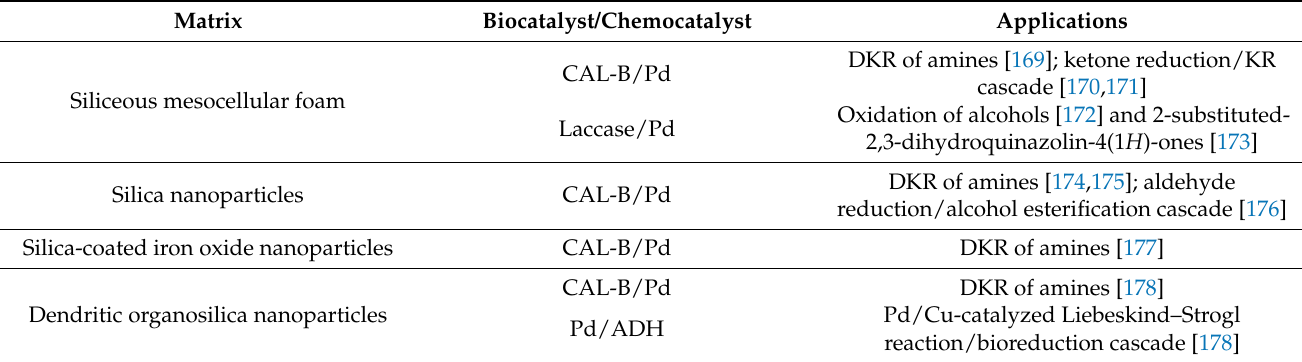
Table 3. Matrices used in the co-immobilization of chemo- and biocatalysts. CAL-B = Candida antarctica B lipase, DKR = dy- namic kinetic resolution, KR = kinetic resolution, ADH = alcohol dehydrogenase, PDA = polydopamine, CAL-A = Candida antarctica A lipase, MOF = metal–organic framework, LAAO = L-amino acid oxidase, NaDC = sodium